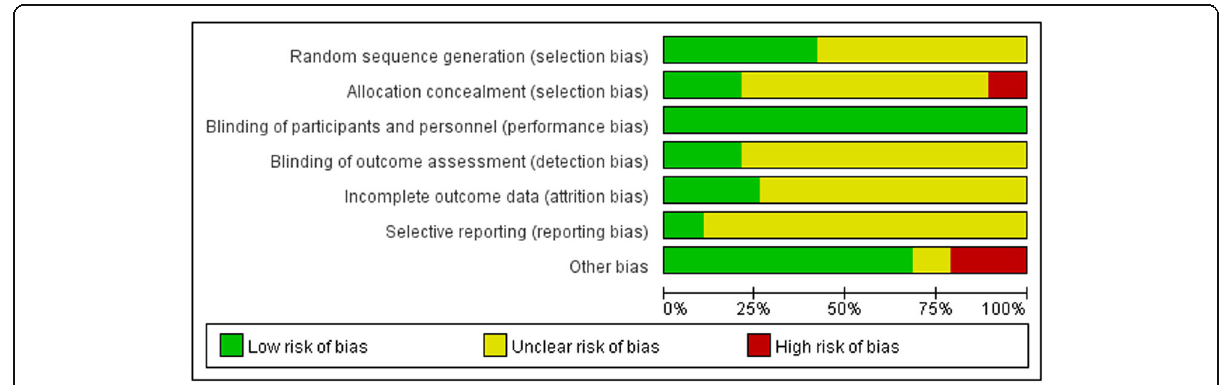
Fig. 2 Risk of bias summary in included